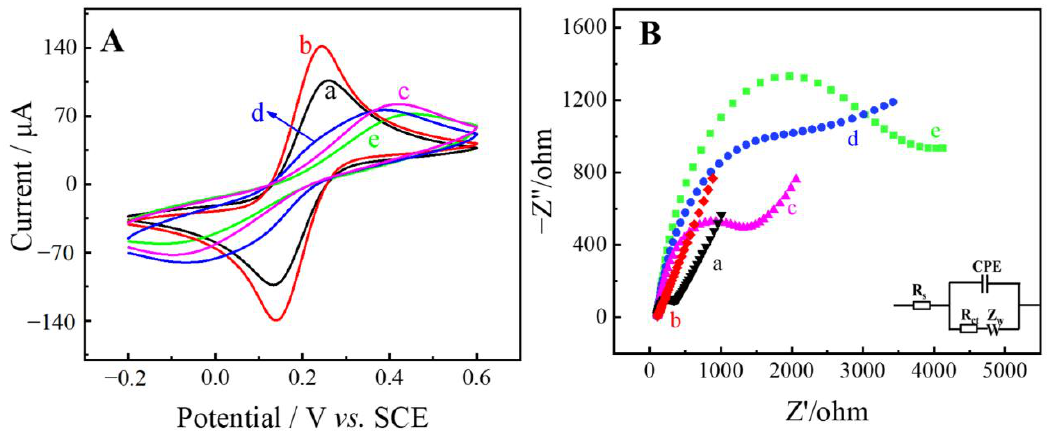
Figure 3. The Cyclic voltammetry ( A ) and Electrochemical impedance spectroscopy ( B ) characteri- zation of the construction process of CAP electrochemical aptasensor (a. bare GCE, b. AuNPs/PCs/GCE, c. Apt/AuNPs/PCs/GCE, d. MCH/Apt/AuNPs/PCs/GCE and e. CAP/MCH/Apt/AuNPs/ PCs/GCE) in 5 mM K 3 Fe(CN) 6 /K 4 Fe(CN) 6 (1:1) solution containing 0.1 M KCl.